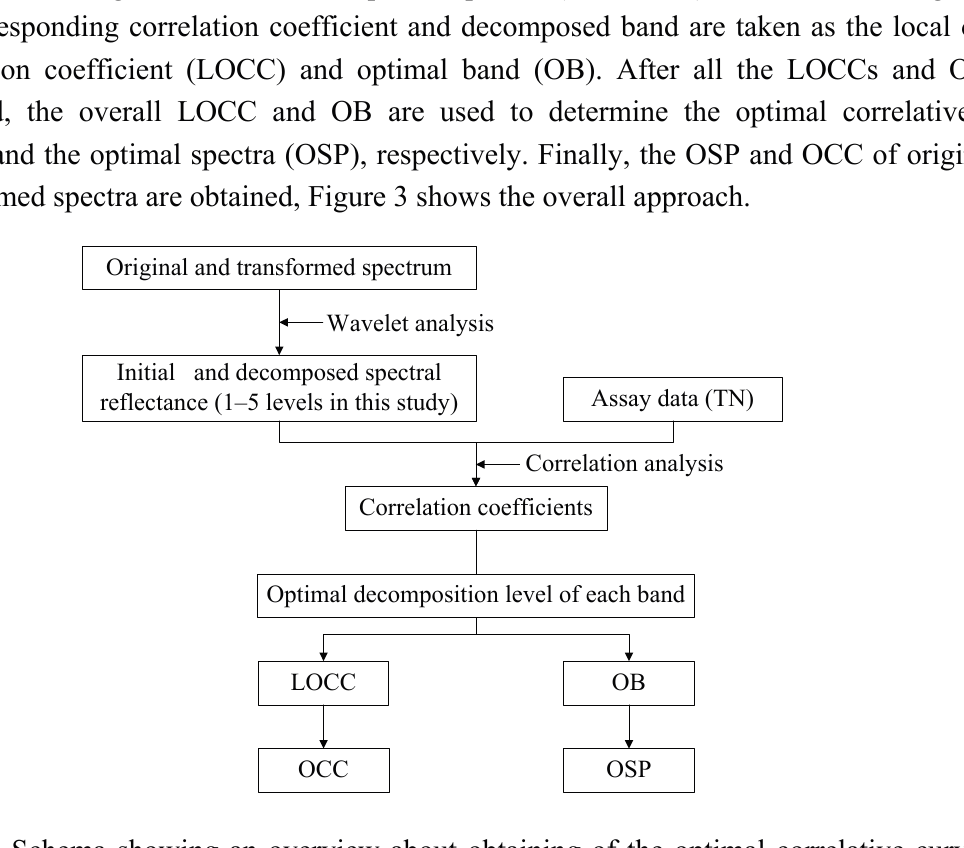
Figure 3. Schema showing an overview about obtaining of the optimal correlative curve (OCC) and the optimal spectra